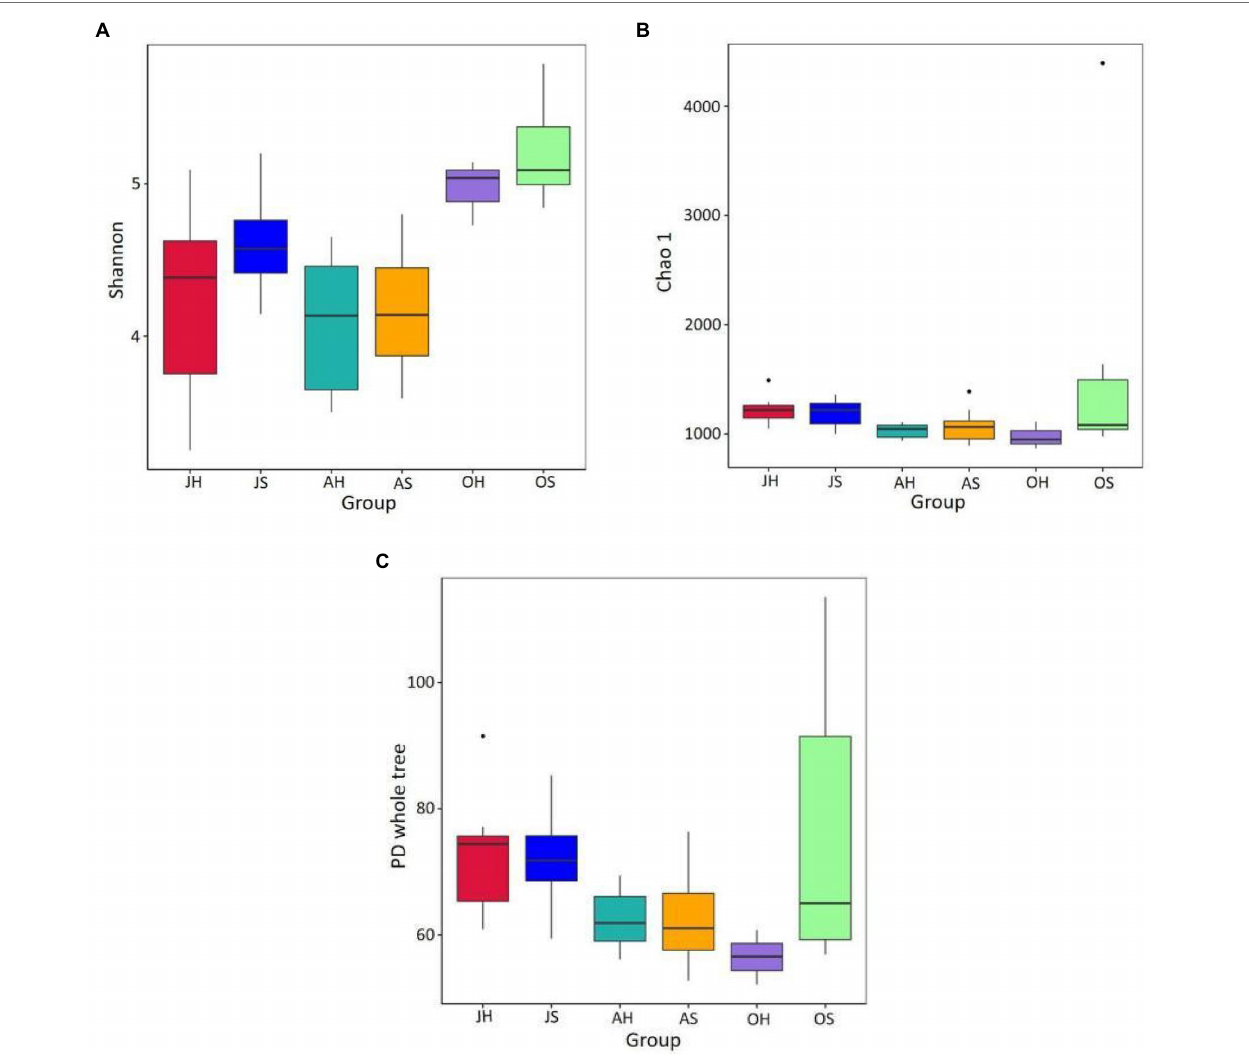
FIGURE 2 | The epiphytic bacteria abundance and diversity in Myriophyllum spicatum from Baiyangdian Lake. Indices of alpha diversity shown as Shannon (A) , Chao1 (B) and phylogenetic diversity (C) . JH, samples in June at Shihoudian Lake; JS, samples in June at Damaidian Lake; AH, samples in August at Shihoudian Lake; AS, samples in August at Damaidian Lake; OH, samples in October at Shihoudian Lake; and OS, samples in October at Damaidian